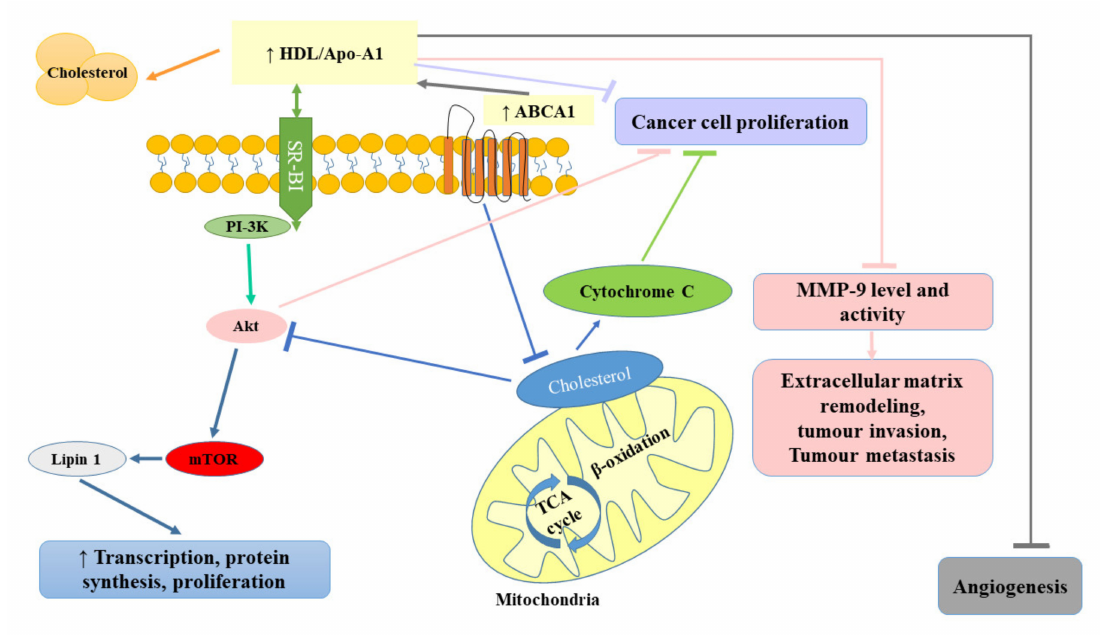
Figure 4. Protective role of high-density lipoprotein (HDL) in cancer development. ABCA1, ATP-binding cassette transporter; Akt, protein kinase B; Apo-A1, apolipoprotein A-I; HDL, high-density lipoprotein; MMP-9, matrix metallopeptidase-9; mTOR, mammalian target of rapamycin; PI-3K, phosphatidyl inositol 3-kinase; SR-BI, scavenger receptor class B type 1; TCA, trichloroacetic acid.